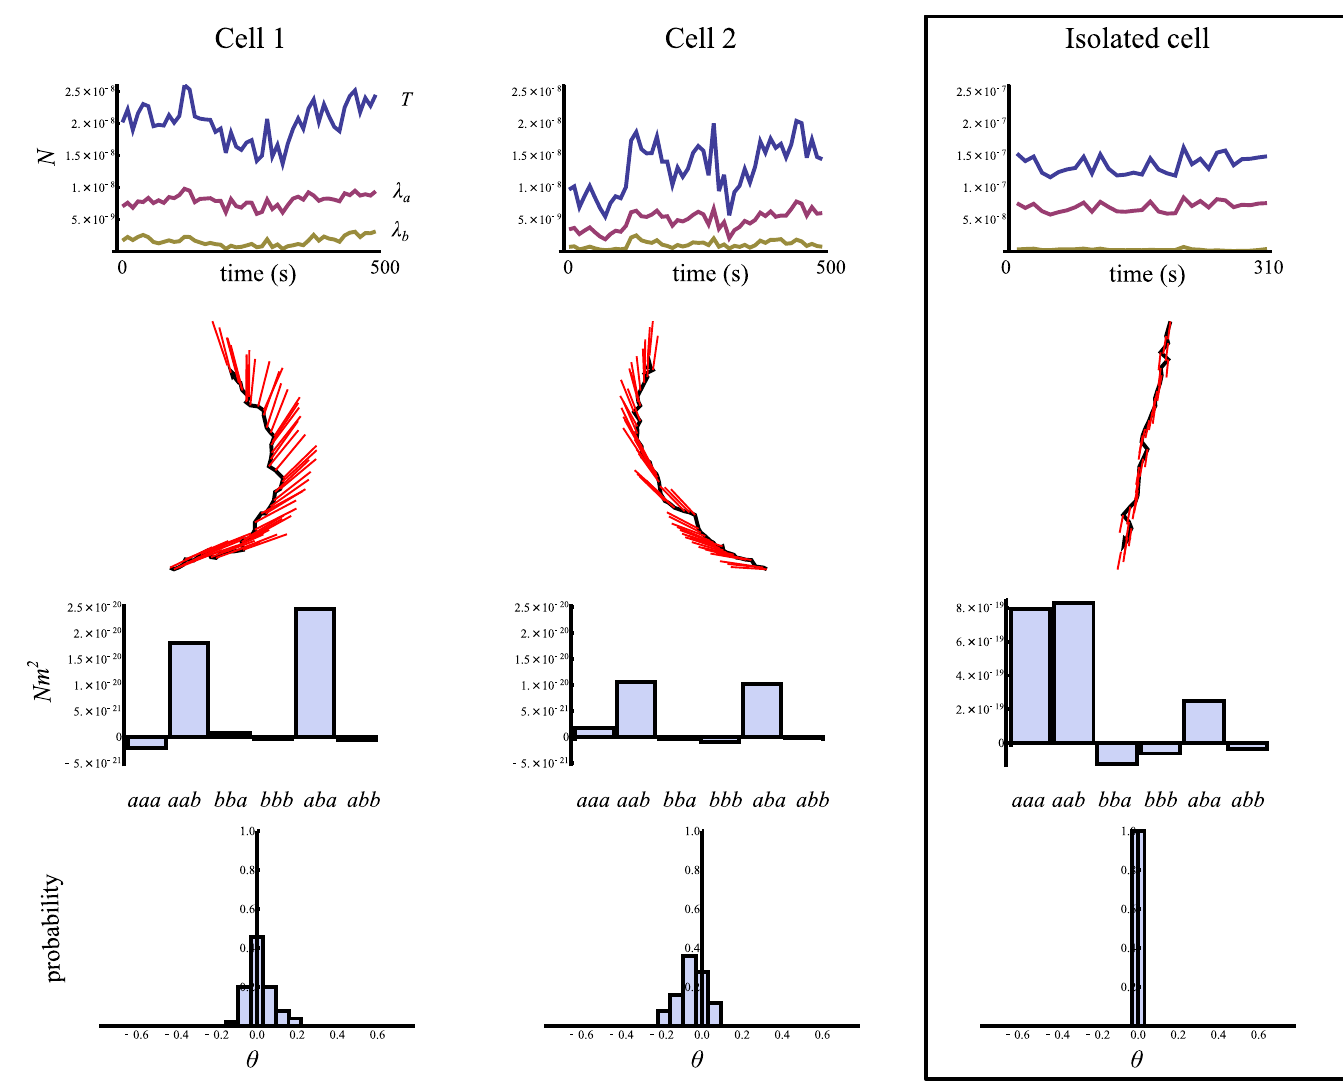
Fig 3. Traction force analysis of the two interacting cells shown in Fig 2A (left 2 columns) and the isolated cell shown in Fig 2D (right column). The top panels give the amplitude of the traction magnitude, in blue ( T ), and the two principal force dipole moments (divided by the square root of the mean cell area), in magenta ( λ ) and yellow ( λ ), as a function of time. The second row of panels shows the small dipole orientation (red lines) at fixed time intervals along the cell trajectories a b (black arrow). The third row shows the observed distribution of the angle between the small dipole and the short cell shape eigenvector. The last row gives the strength (average over the cell trajectory) of the 6 independent quadrupole moments, as explained in the main text and in Eq (5). A sketch of a simple model for the distribution of traction forces within the cell that accounts for the most important quadrupole moment, aab , is shown in the left panel of Fig 4. As explained in the text and in S1 Appendix, the other large quadrupole components are trivial corrections to a perfect dipole. In the figure, N and m are the SI units of force and